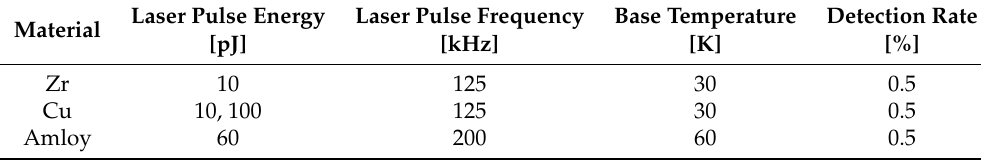
Table 1. Atom probe tomography measurement parameters.